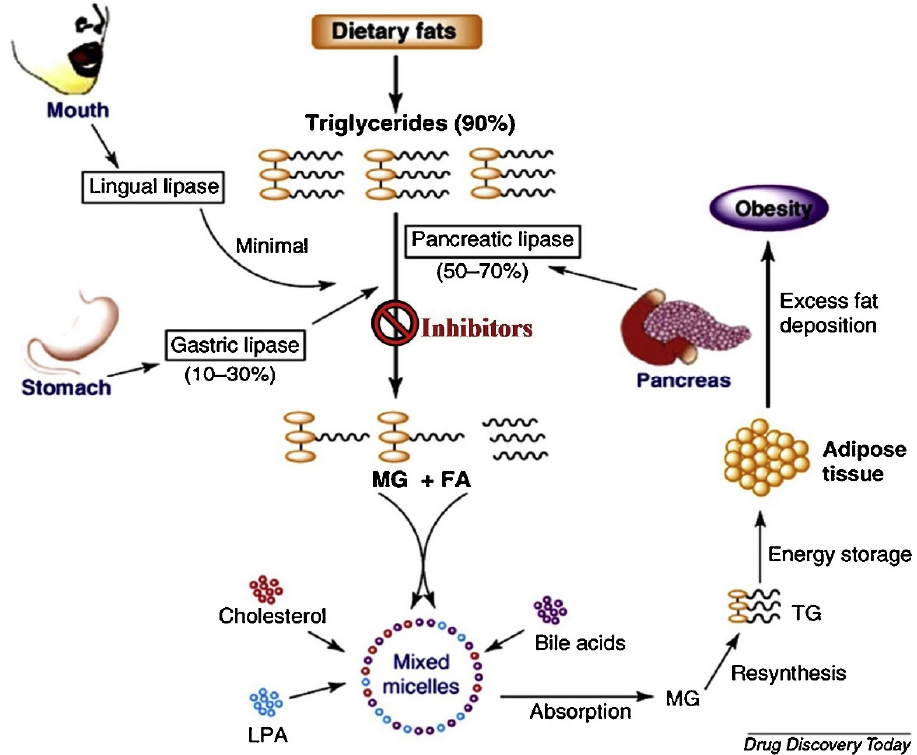
Figure 1. Lipids metabolism in humans and the role of PNLIP in these metabolic pathways [1], under a Creative Commons license.